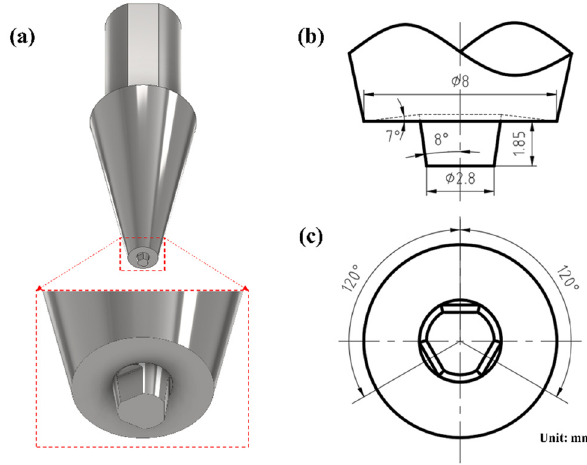
Figure 1: Schematic draft of the tool: ( a ) the tool, ( b ) and ( c ) dimensions of shoulder and pin.